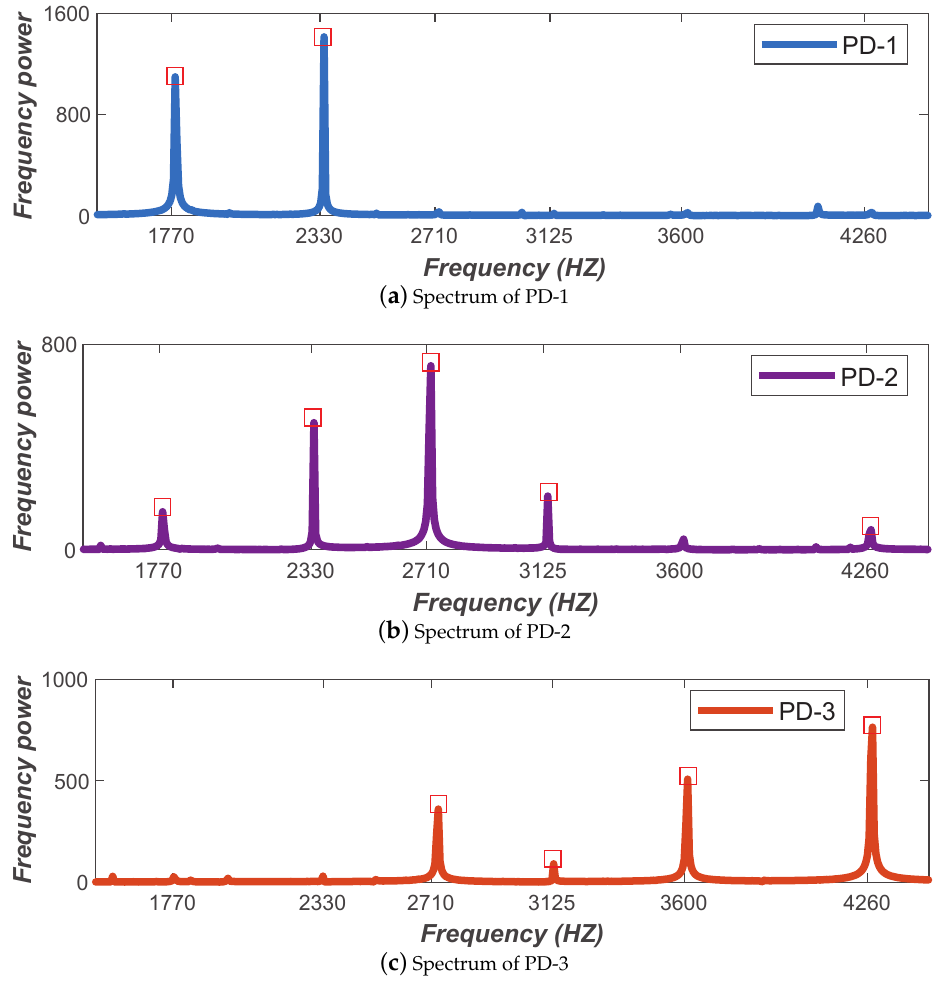
Figure 11. Personnel counting